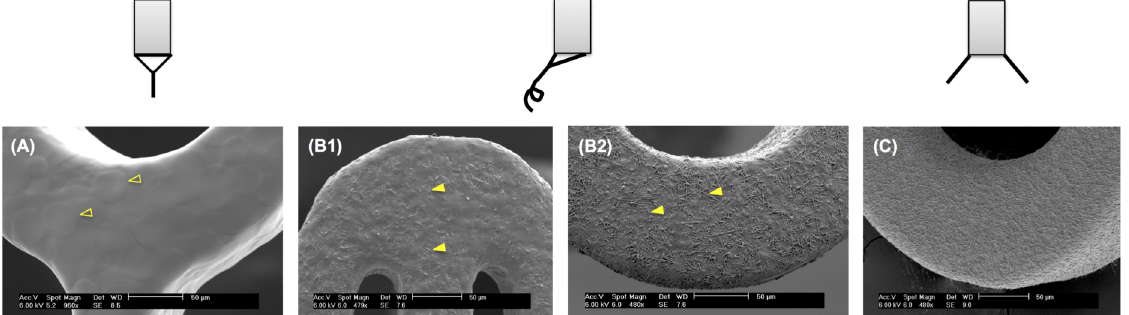
Fig 5. Coating morphology obtained at different electrospraying modes. SEM images of Express coronary stents coated by electrosprayed droplets obtained at different electrospraying modes: (A) cone-jet mode, (B) precession mode, and (C) multi-jet mode. These electrospraying modes were achieved at an increasing electric field of (A) 1.5 kV/cm, (B1) 1.6 kV/cm, (B2) 1.7 kV/cm, and (C) 1.8 kV/cm, respectively. Round and stretched deposited droplets were highlighted in empty yellow triangles (A) and solid yellow triangles (B),